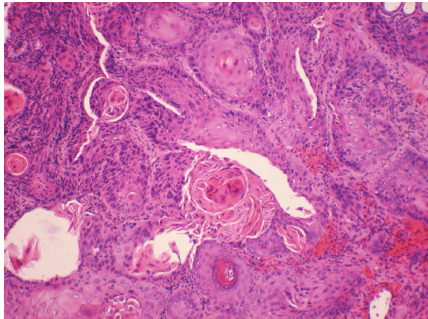
Figure 2: Neck soft tissue Magnetic resonance imaging showing heterogeneous signal abnormality and enhancement centered about the right external auditory canal and middle ear region. The arrow depicts spread of the tumor into the middle ear.